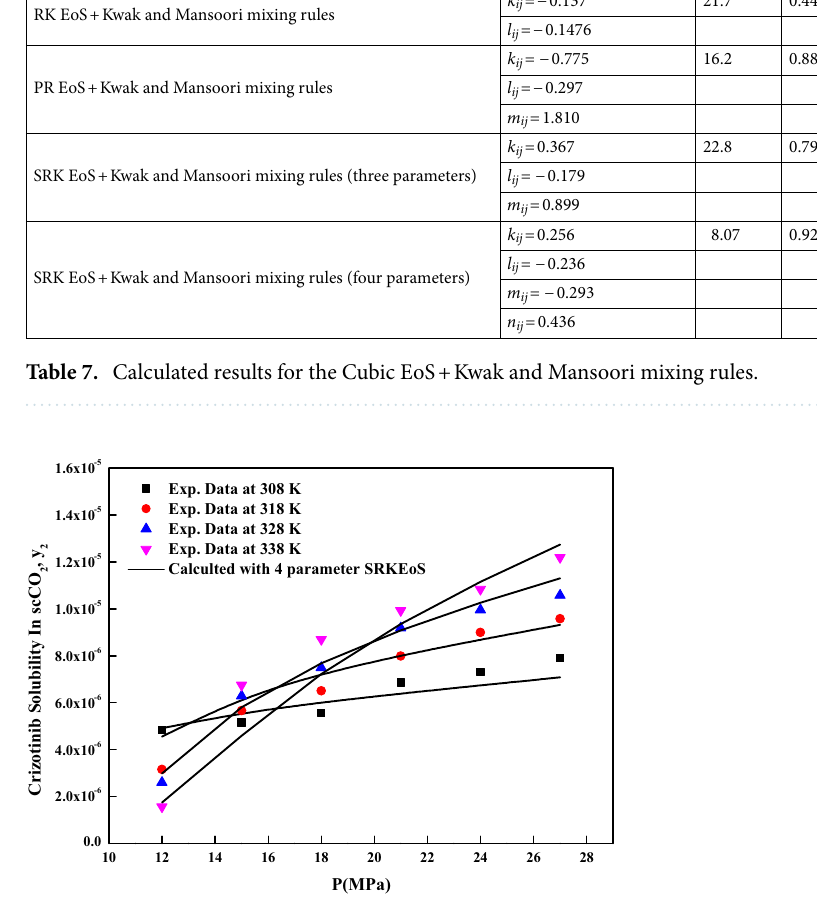
Figure 7. Crizotinib solubility in scCO 2 vs. P. Symbols are experimental data points. Solid lines are calculated solubilities with SRK EoS + Kwak and Mansoori mixing rules (four parameters